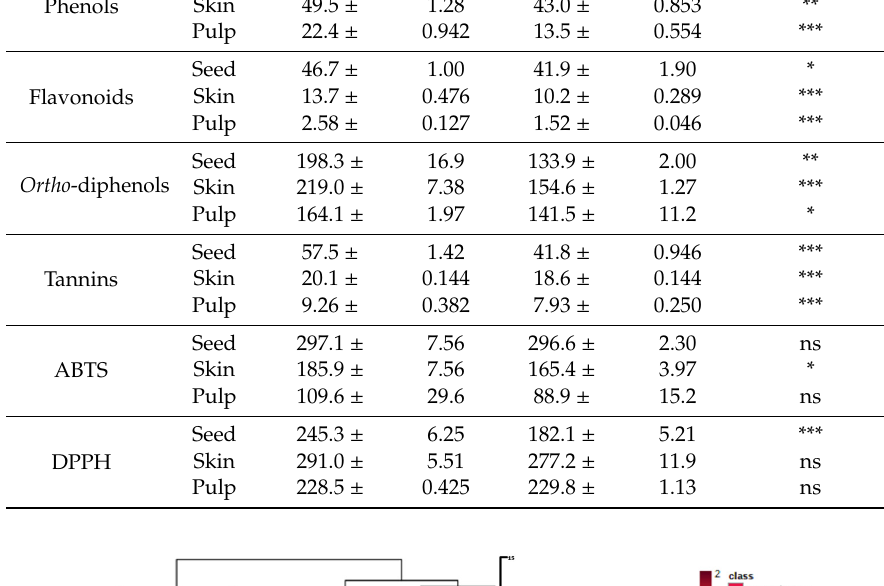
Table 5. Phenols, flavonoids, ortho -diphenols and tannins, and antioxidant activity (ABTS and DPPH) (mg g − 1 DW) in the seeds, skins, and pulps of fruits from Kl treated and untreated (control) plants. Values are presented as mean ± SD. Significant di ff erences were presented between treatments and considered for p < 0.05 and *** p < 0.001, ** p < 0.01, * p < 0.05 represent significant di ff erences; ns indicates no significant di ff erences.